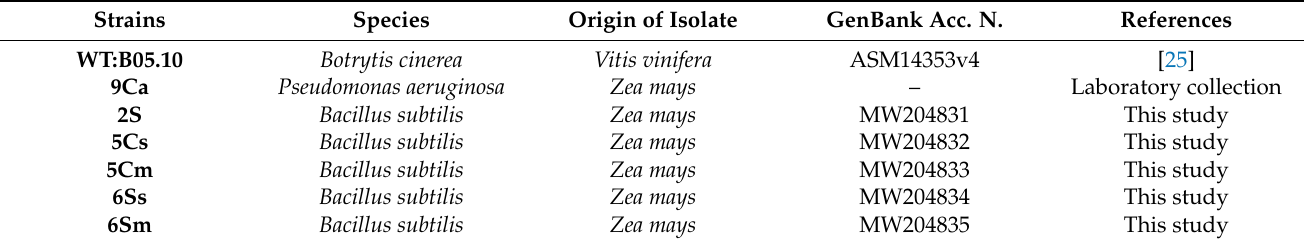
Table 1. Strains used in this